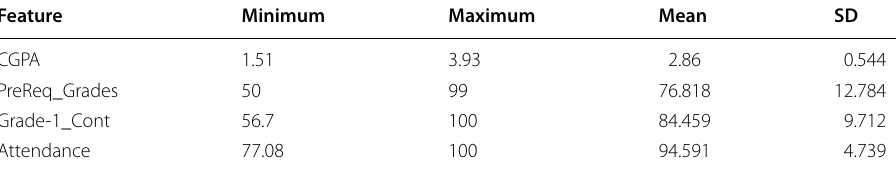
Table 4 The significant features and their descriptive analysis